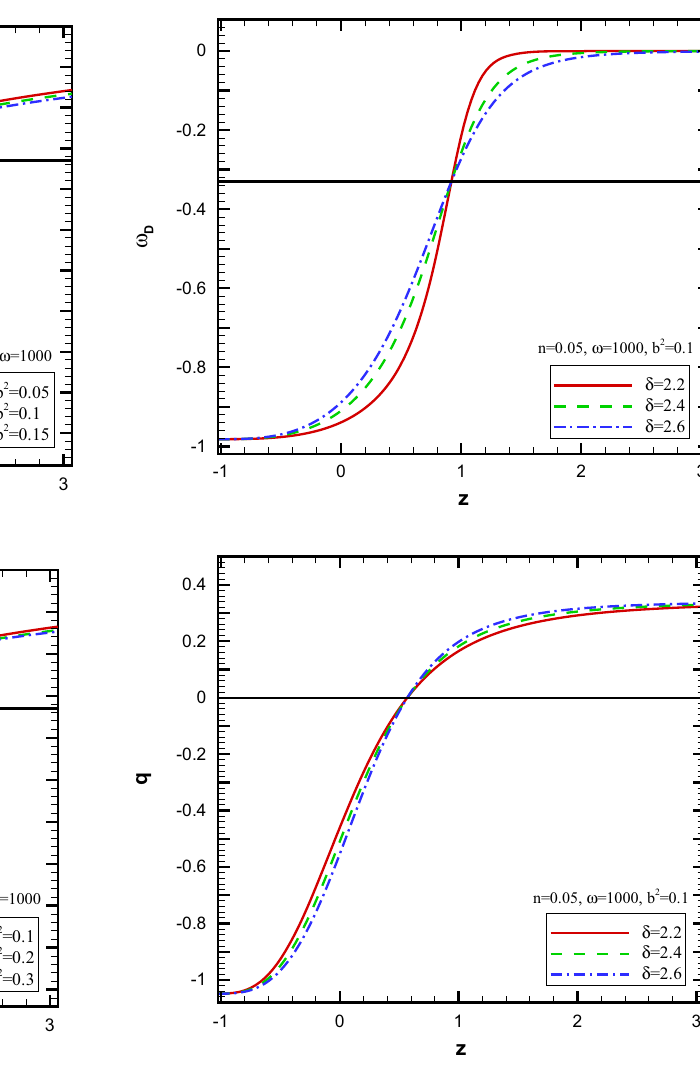
Fig. 5 The evolution of ω D versus z for the interacting THDE, where (cid:3) = 0 (upper panel), (cid:3) = 0 . 1 (lower panel), δ = 0 . 6, n = 0 . 05 and k k 0 ω = 1000 are adopted as the initial conditions